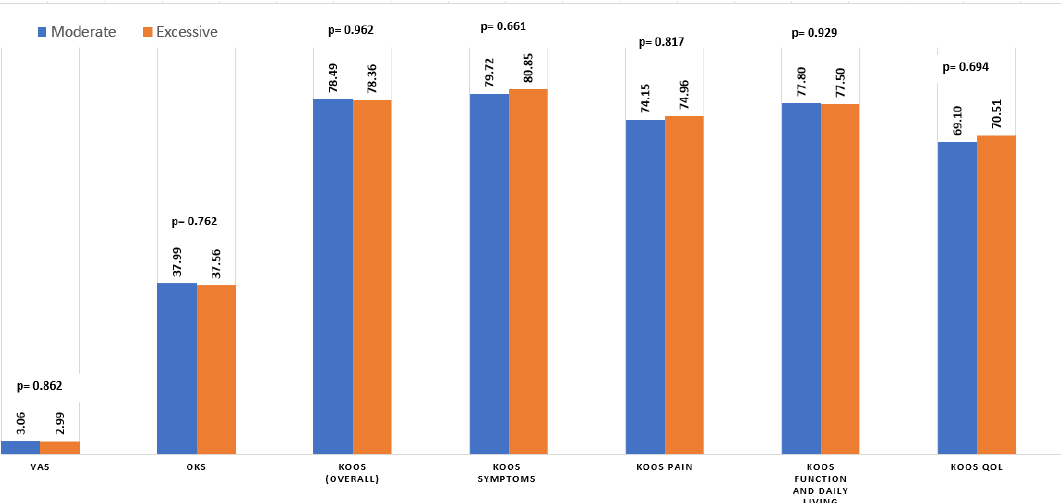
Figure 2. Average patient-reported outcome scores in the moderate versus excessive PTS groups, postoperatively. Abbreviations: (KOOS) Knee Injury and Osteoarthritis Outcome Score; (OKS) Oxford Knee Score; (VAS) visual analog scale; (QOL) quality of life. Table 3. Number and percentage of patients achieving minimal clinical differences (MCID) of the Oxford Knee Score (OKS) and the Knee Injury and Osteoarthritis Outcome Score (KOOS) subcate ‐ gories in the restricted versus excessive groups.